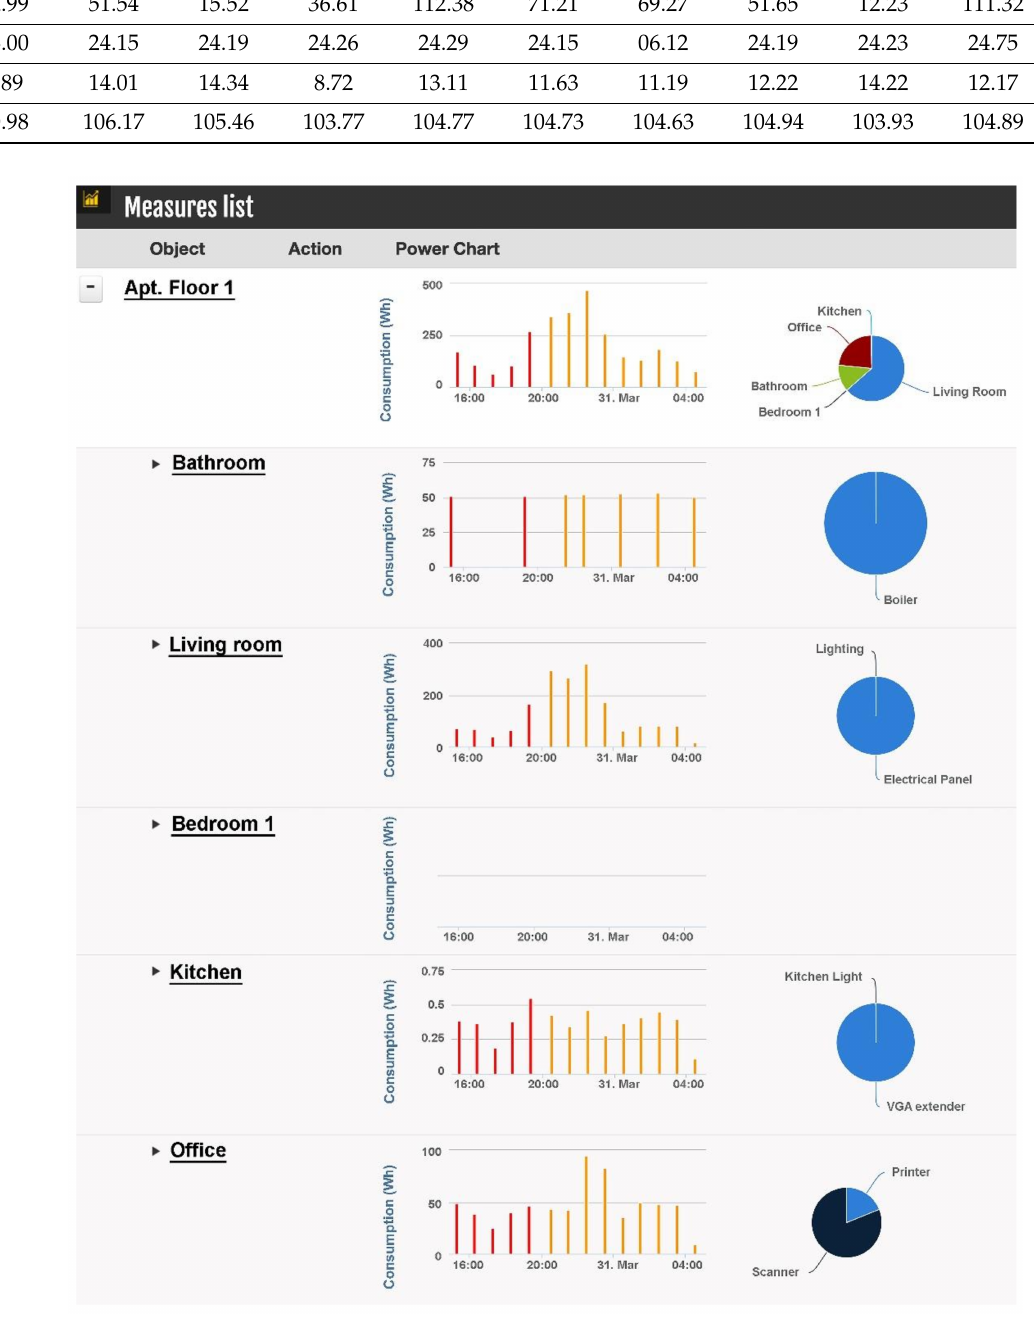
Figure 18. Submetering in a typical apartment. Energy consumption of each device varies according to its power absorption, as shown in Table 6 and Figures 18 and 19, which report some controlled measures on a typical working day, detailing both the apartment and the single